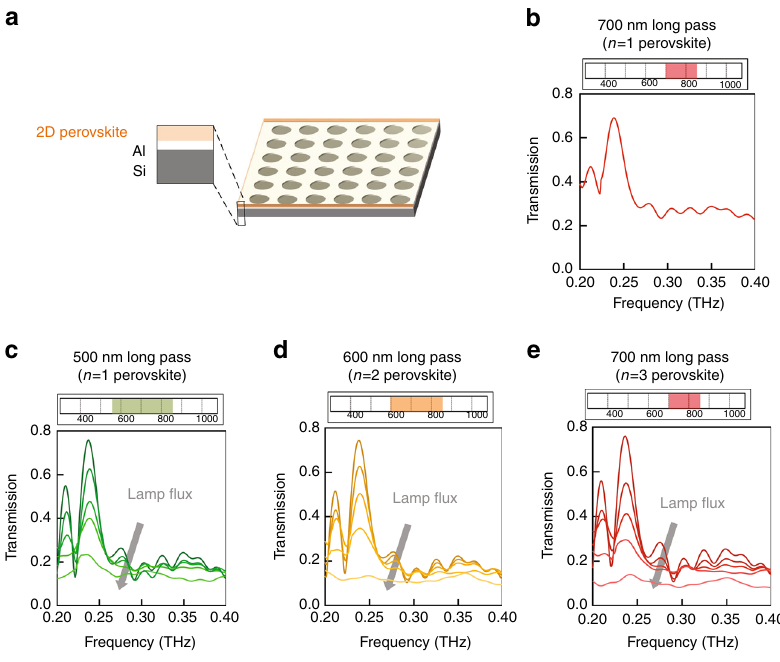
Fig. 3 Attenuation of THz plasmonic resonances. a Schematic diagram of the device composed of a high resistivity silicon substrate with a 200 nm perforated aluminum fi lm topped by a 200 nm thick 2D perovskite thin fi lm. b Transmission spectrum of the aperture array demonstrating negligible attenuation for the n = 1 perovskite/Si sample when excited with 700 nm long pass fi lter (i.e., no excitons are generated). c – e Optical excitation induced attenuation of the transmitted THz transmission through the metallic hole array. The dips on the high frequency side of the two lowest order resonances occur at . These arrays were excited using 500 nm long pass, 600 nm long pass, and 700 nm long pass fi lters, respectively. The optical excitation range is shown above each spectrum. Nearly 100% attenuation of the plasmonic resonances was achieved as the lamp fl ux was increased (the arrow direction corresponds to increasing lamp fl schematic diagram of the experimental setup is shown in Fig. 2b, with the corresponding data shown in Fig. 2c.